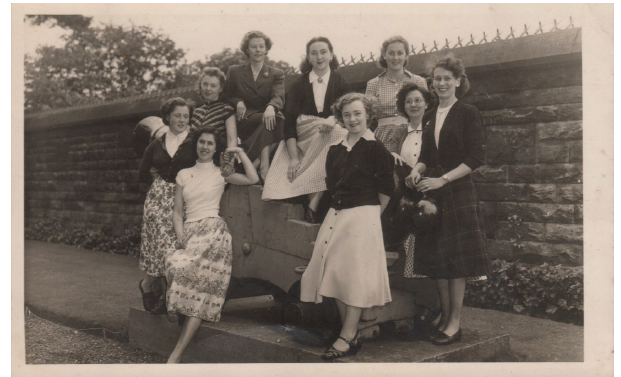
Figure 4. A group photograph of the team of computers at Bid- ston Observatory in 1953. (Photo: Valerie Gane.) They are gathered around the original Liverpool One O’Clock Gun which, when lo- cated in Birkenhead Docks, was fired by means of transmission of an electrical signal from the